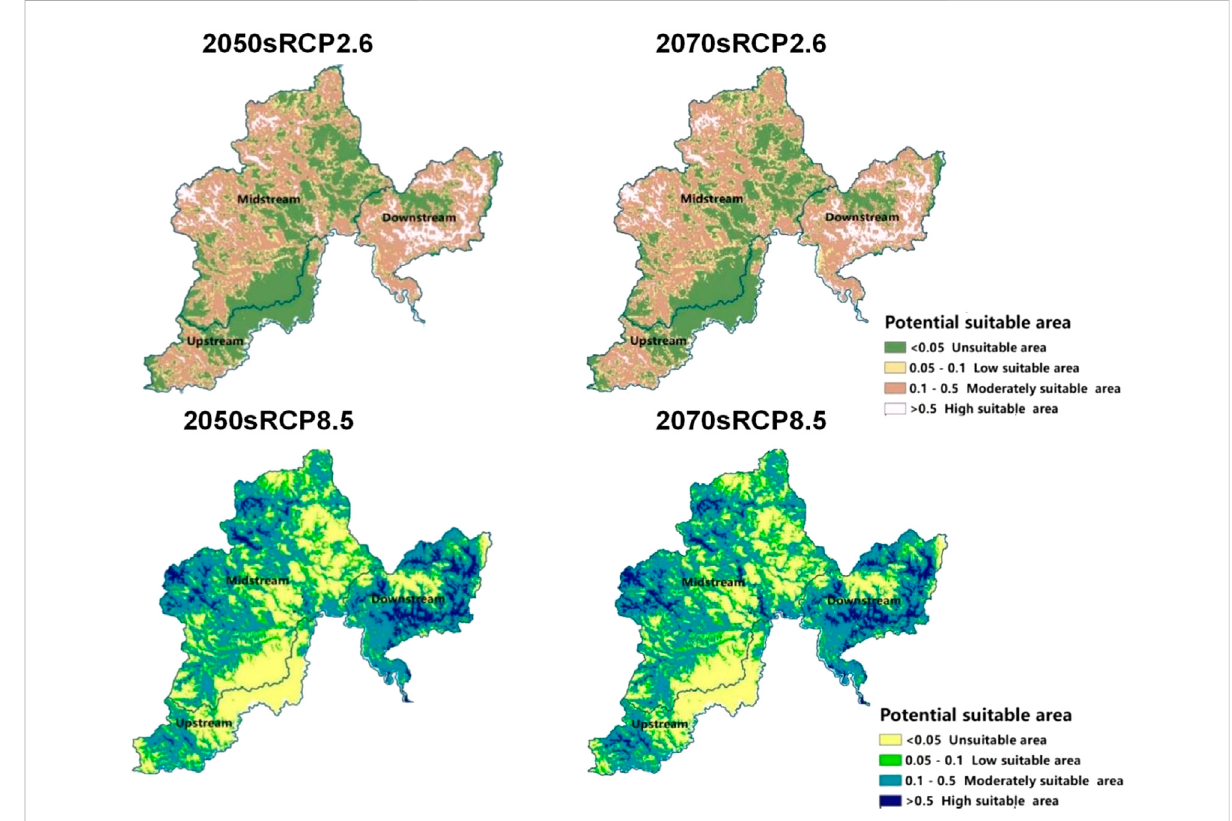
FIGURE 5 Distribution map of future ecological suitability of Deyeuxia